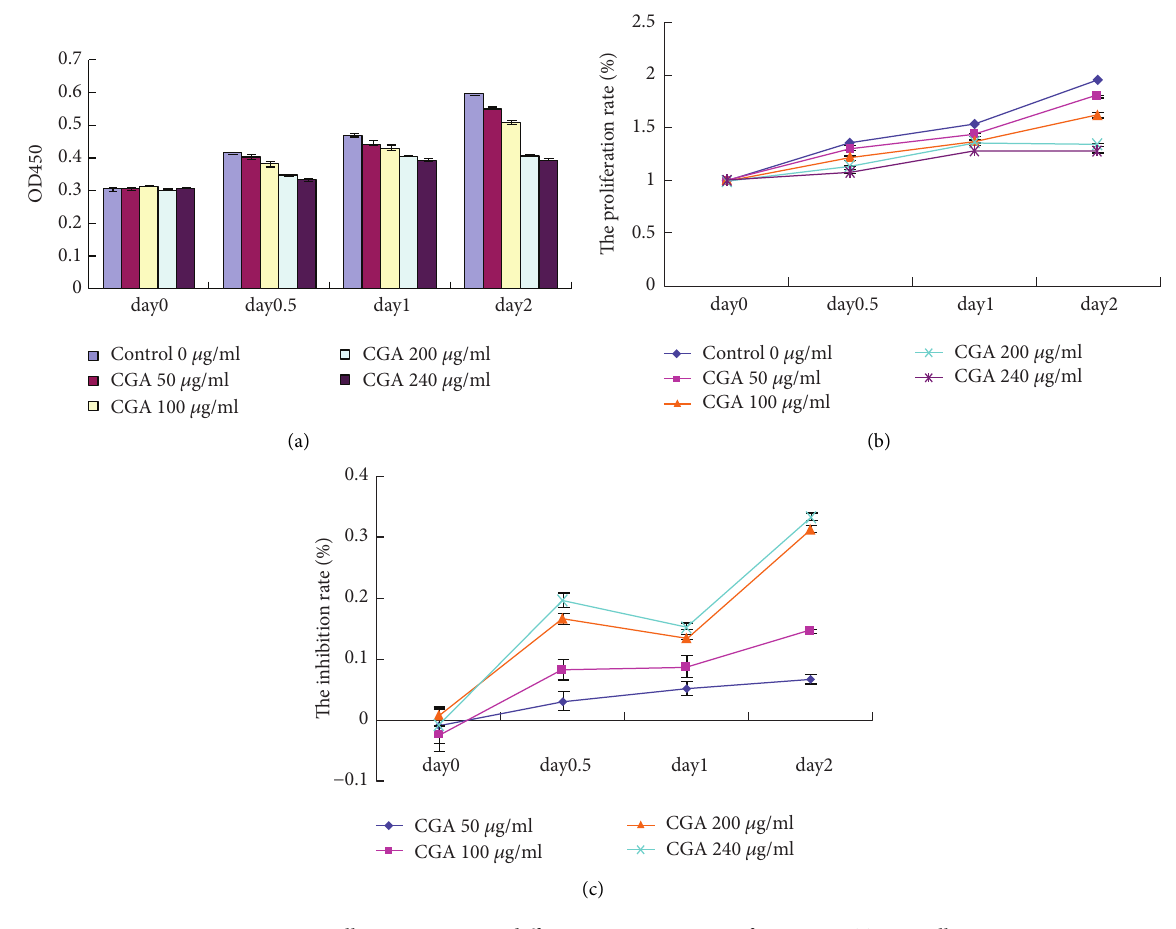
Figure 2: Cell toxicity test on different concentrations of CGA on 3T3-L1